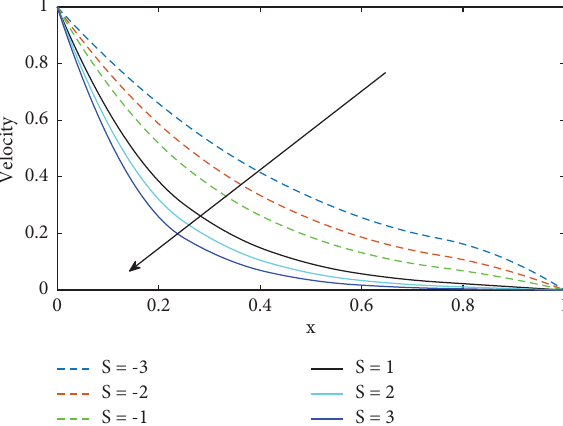
Figure 6: Velocity profles for diferent values of S .